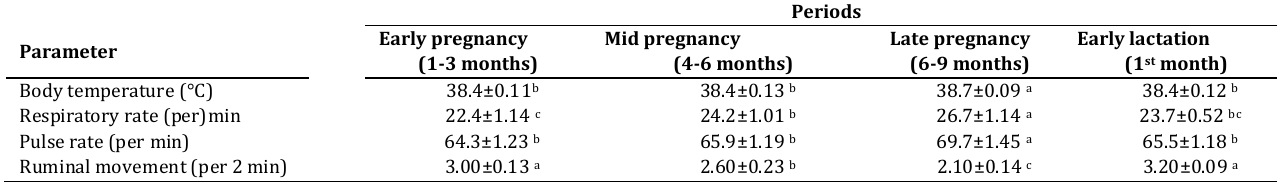
Table 1. Clinical signs through pregnancy periods and early lactation